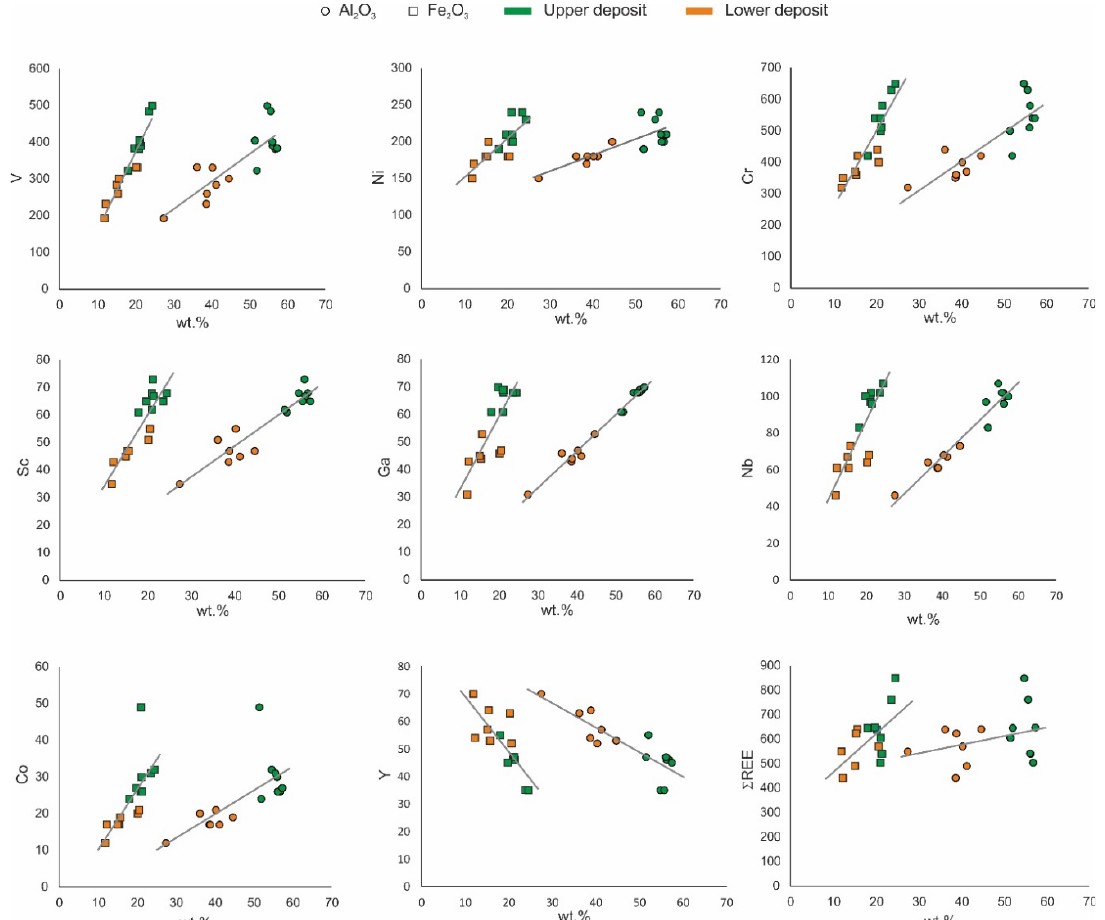
Figure 7. Binary plots showing positive and negative correlations of the Al 2 O 3 and Fe 2 O 3 contents (wt.%) with those of the main trace elements and Σ REEs (ppm). See text for further details.